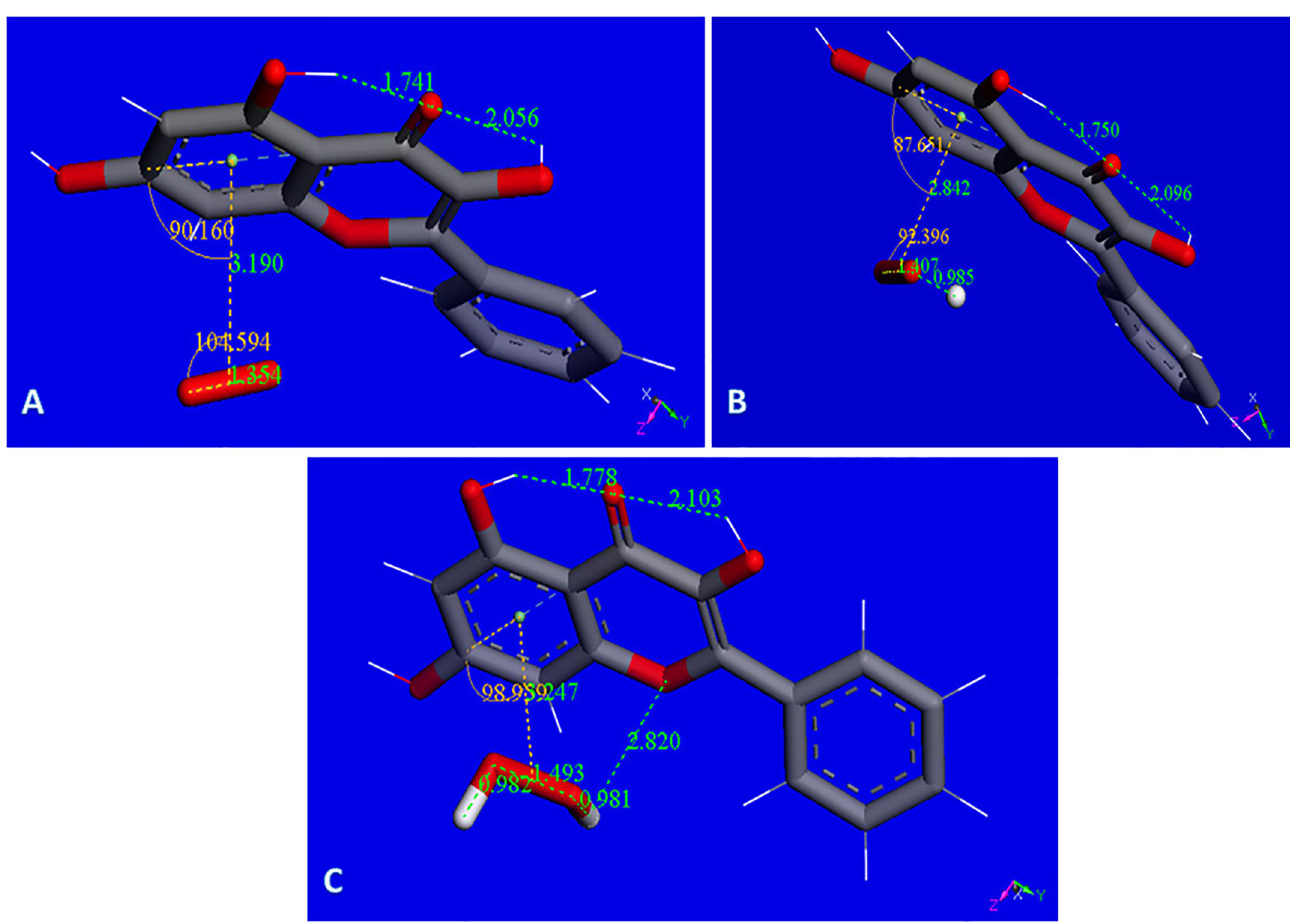
Fig 7. A: Galangin accepts a π - π approach by superoxide. Initially van der Waals separated molecules, 3.50 Å , are geometrically optimized. Both reagents become closer with centroid-centroid separation stabilized 3.190 Å apart. There is a slight shortening of O-O bond distance in superoxide, 1.354 Å , from the original 1.373 Å ; B: Galangin π – π superoxide from previous Fig 7A is now approached by a proton that, after minimization, becomes stabilized by formation of an O-H bond, 0.985 Å , while superoxide O-O separation is lengthened, 1.407 Å (it was 1.354 Å in Fig 7A); C: From previous Fig 7B, an additional proton is placed 2.60 Å from HO 2 . Upon minimization H 2 O 2 is formed, however, it is in a complex with the galangin ring, as shown by the centroid-centroid separation of 3.247 Å , shorter that the 3.50 Å π – π van der Waals